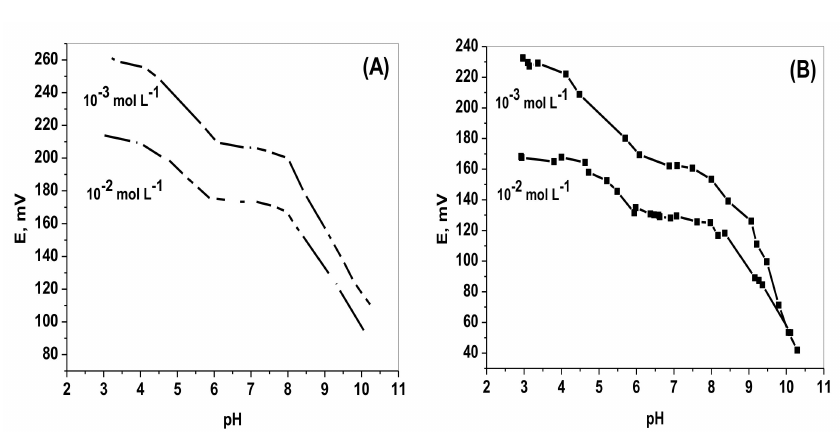
Figure3. InfluenceofpHonpotentiometricresponseof: ( A )Paper, and( B )ceramicbasedChromium(VI) sensors with PANI solid